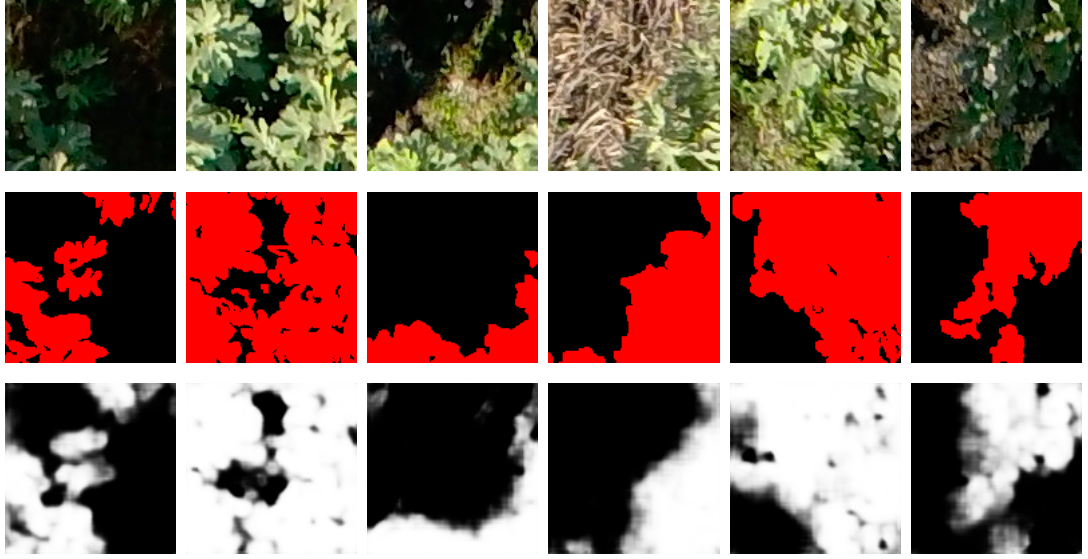
Figure 8. Qualitative results of six test patches: RGB image input (first row), GT (second row) and Predictions (third row).